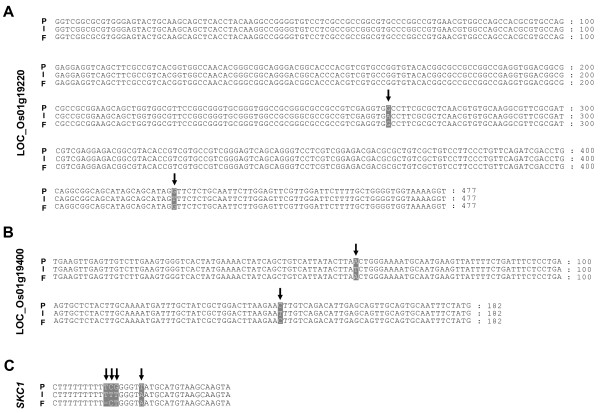
Alignments of amplicon sequences of genes in a small segment of the Saltol region from the non-IR29 parent. Polymorphic residues of (A) LOC_Os01g19220, (B) LOC_Os01g19400 and (C) LOC_Os01g20160 (SKC1 gene) are highlighted in gray. Arrows indicate SNPs or INDEL. P, Pokkali; I, IR29; F, FL478.